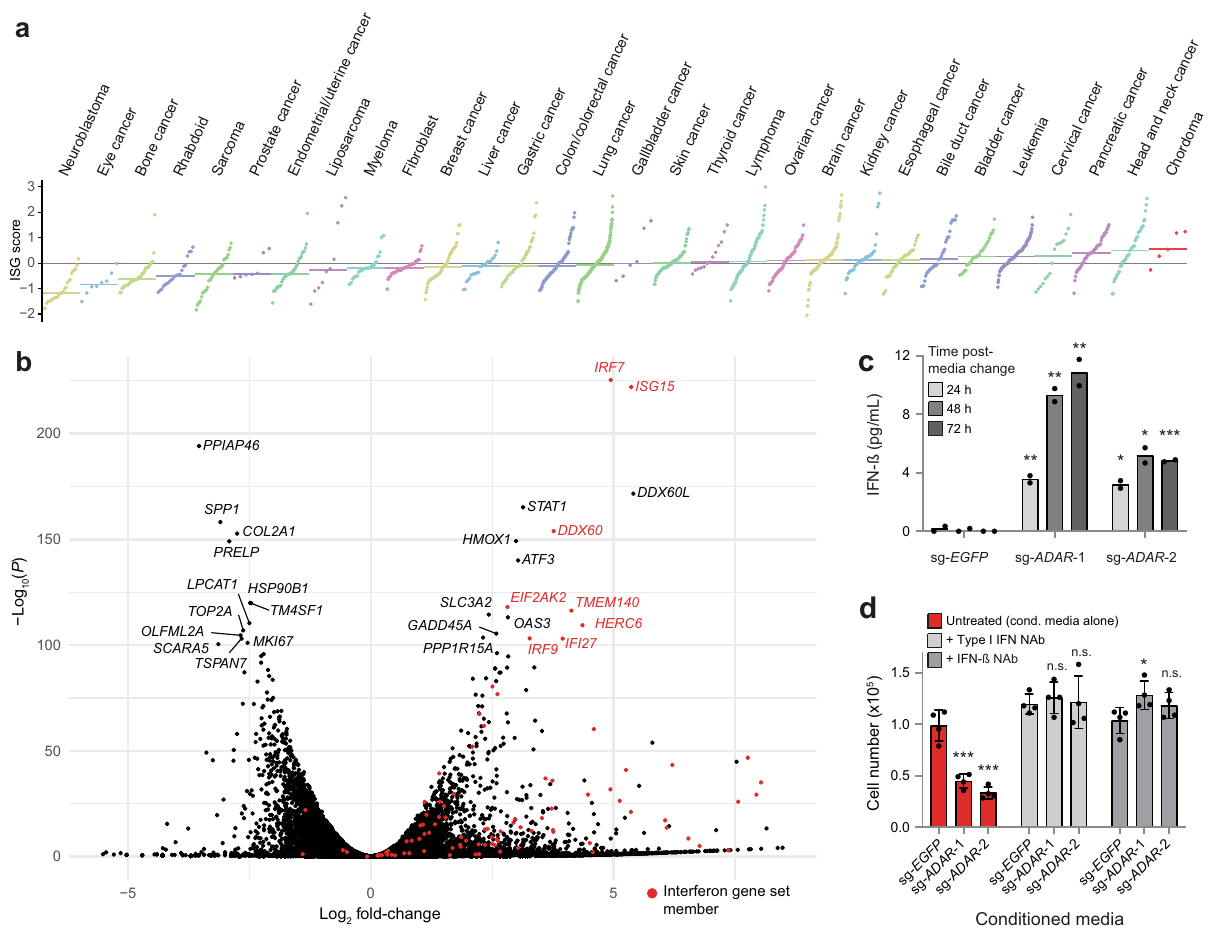
Fig. 4 | Interferon-stimulated genes are overexpressed in chordoma cells and further upregulated following ADAR gene suppression. a Distribution of ISG corescores 37 forchordomacelllinesand1294non-chordomacancercelllinesinthe CCLE, grouped by lineage annotation. Colored horizontal bars: median scores for each group. Gray horizontal line: zero-score mark. b Differential gene expression comparing the average effects of two distinct ADAR -targeting sgRNAs to a non- targeting sgRNA control in Cas9-expressing UM-Chor1 cells. Gene expression was measured with RNA sequencing. P values were derived from a Wald test and Benjamini – Hochberg adjusted. Members of the MSigDB Interferon Alpha gene set are indicated in red. c IFN- β levels in conditioned media harvested from Cas9- expressingUM-Chor1cellstransducedwiththeindicatedsgRNAsandsubsequently subjected to a media change after selection for infected cells. IFN- β levels were measured by ELISA. Data represent the mean of two technical replicates. * P